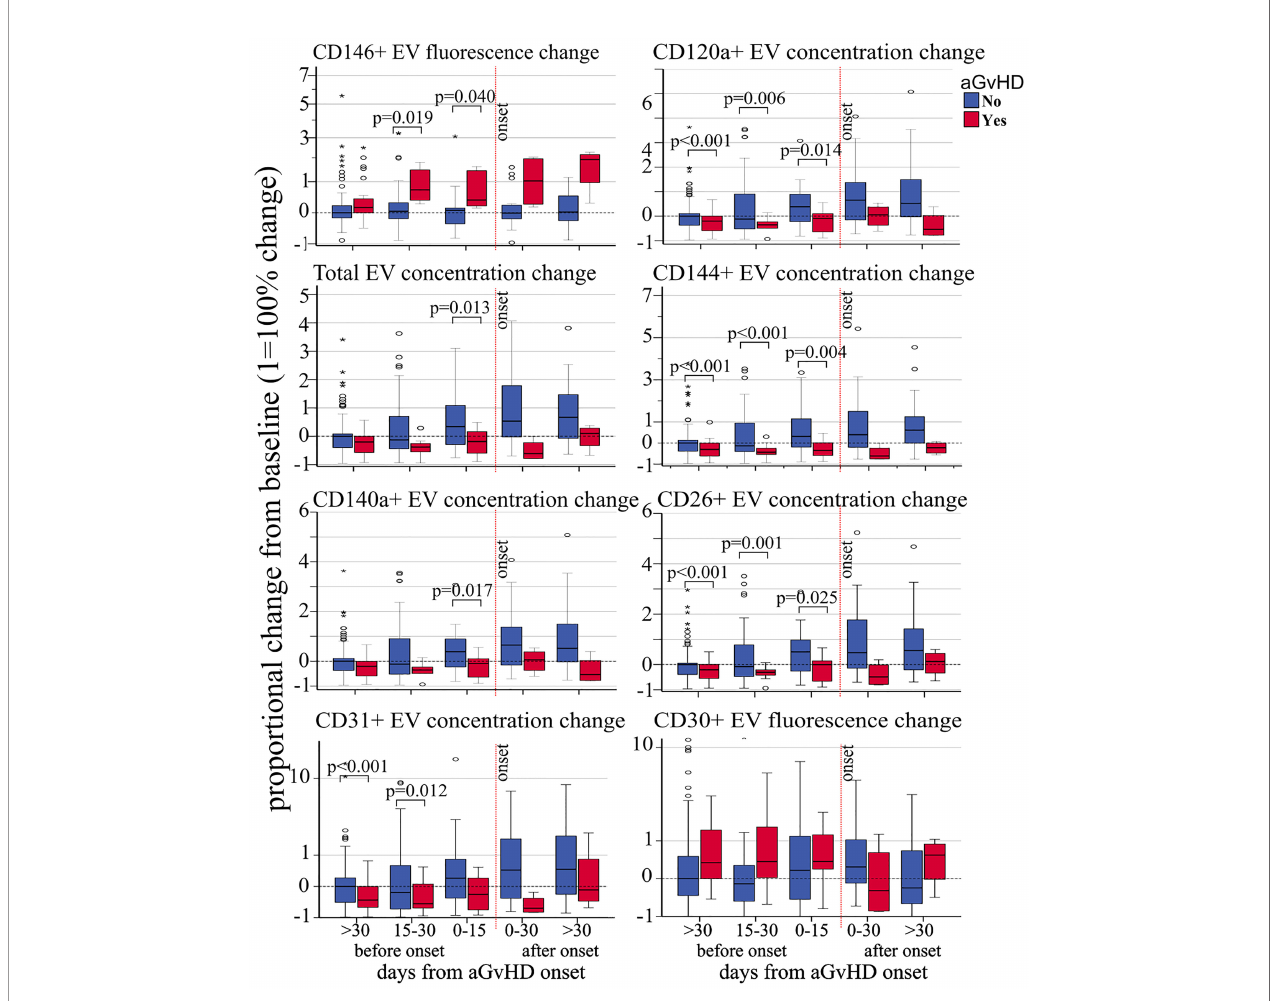
FIGURE 2 | Impact of acute GvHD onset on the kinetics of EV membrane protein expression. Proportional change of fl uorescence levels of CD146, total EV concentration, CD140a + EV concentration and CD31 + EV concentration (left side, from top to bottom), CD120a + EV concentration, CD144 + EV concentration, CD26 + EV concentration, and fl uorescence levels of CD30 from precipitated EVs at different time points before and after aGvHD onset and compared to the pre- transplant baseline values. Dashed black line: pre-transplant levels; dashed red line: time of aGvHD onset; circle and star dots represent outliers (>1.5 box length from median) and extreme values (>3 box length from median), respectively. Signi fi cant mean differences before the onset (p ≤ 0.05) between patients with aGvHD (red) and without (blue) are